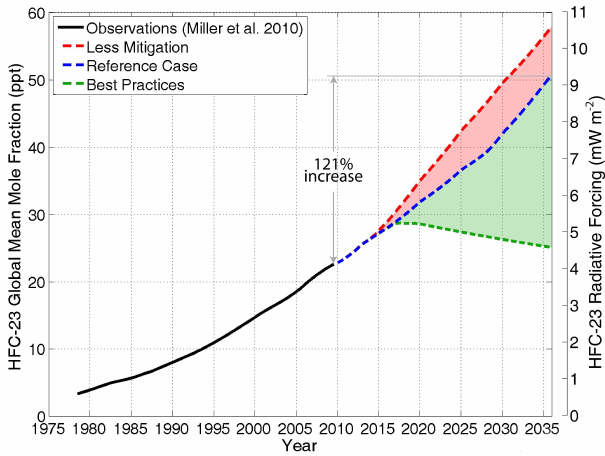
Fig. 3. Global HFC-23 atmospheric abundance (left axis) and radia- tive forcing (right axis) from observations (solid black line) (Miller et al., 2010) with projections based on the three emission scenarios of Fig. 2. The Reference Case scenario suggests that the nearly lin- ear trend observed since ∼ 1995 could continue well into the next two decades, followed by a sharp upturn with expiration of the ac- creditation periods of Clean Development Mechanism projects that incinerate the HFC-23 co-produced during HCFC-22 production in the developing world. Relative to the 2009 global atmospheric abundance of 22.8ppt, the RC scenario suggests a 121% increase by 2035, and the LM scenario suggests a 153%